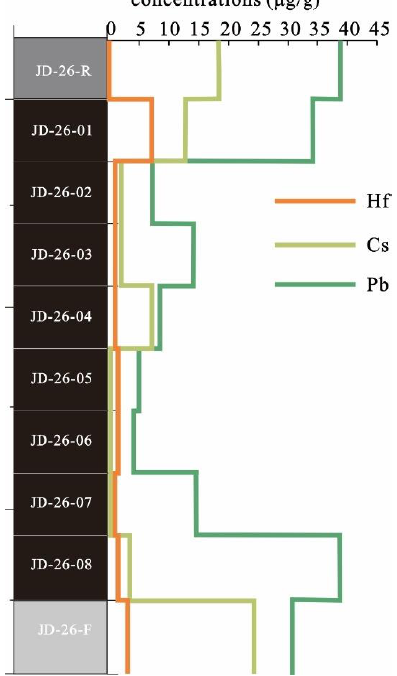
Figure 6. Variations of Hf, Cs, and Pb contents in the Junde mine. Table 4. Concentrations of trace elements in Junde mine samples, on a whole coal basis ( μg/g ).